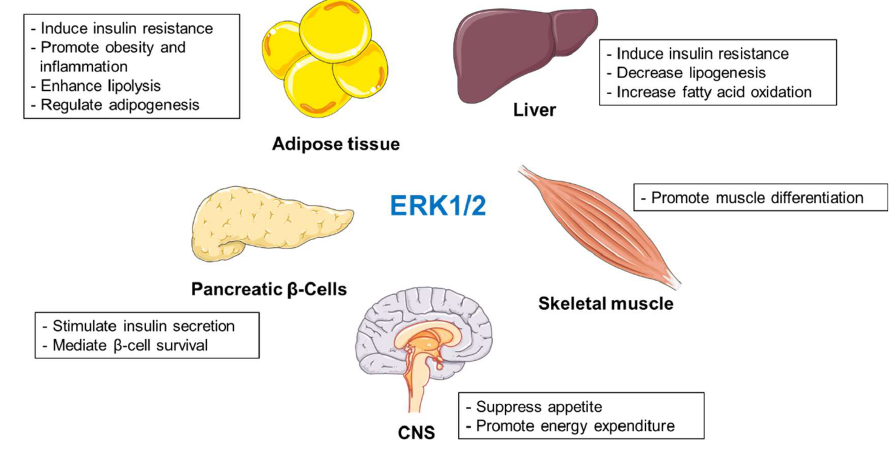
/ 2 in regulation of Figure 1. Roles of ERK1/2 in regulation of metabolism. Figure 1. Roles of ERK1